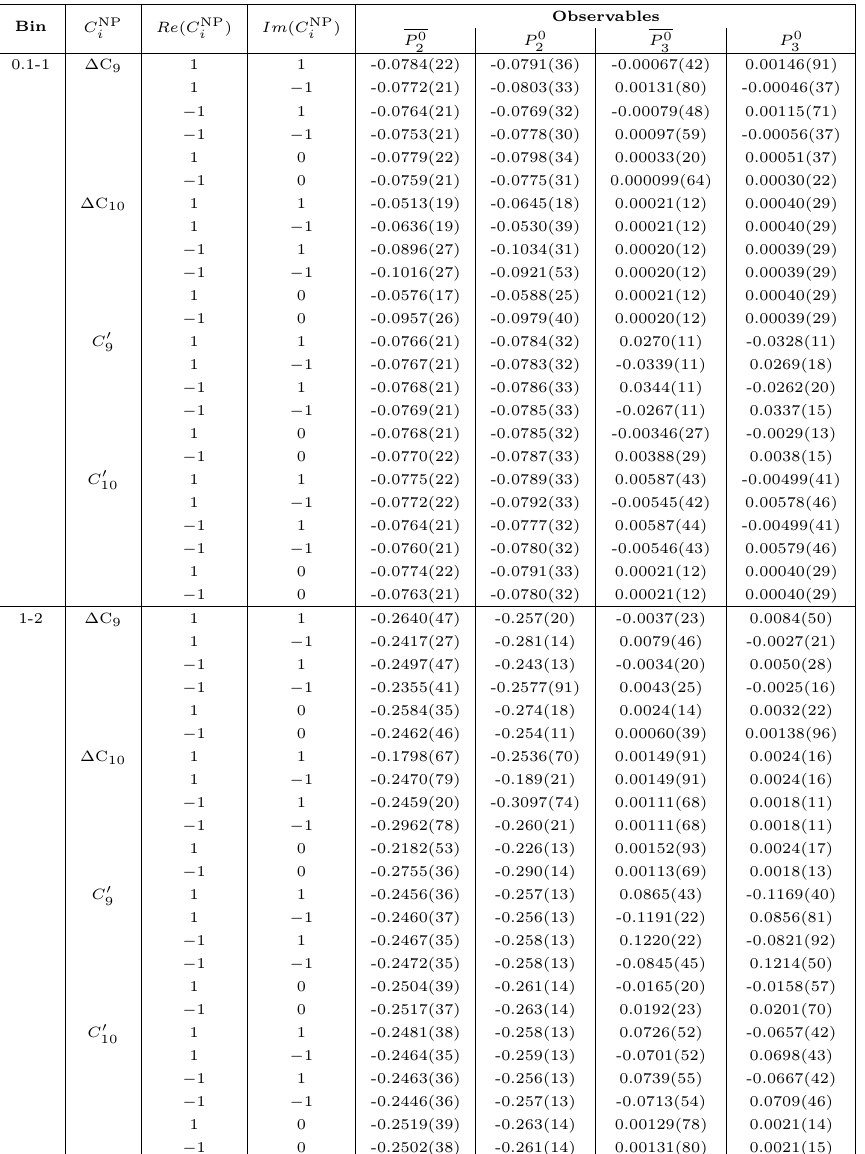
Table 32 . The dependence of some of the optimized observables corresponding to tagged and B 0 → ρ 0 ll on the real and imaginary parts of the NP WC’s ∆ C bins 0 . 1 − 1 and 1 − 2 GeV 2 for a few benchmark values of the real and imaginary parts of the corresponding